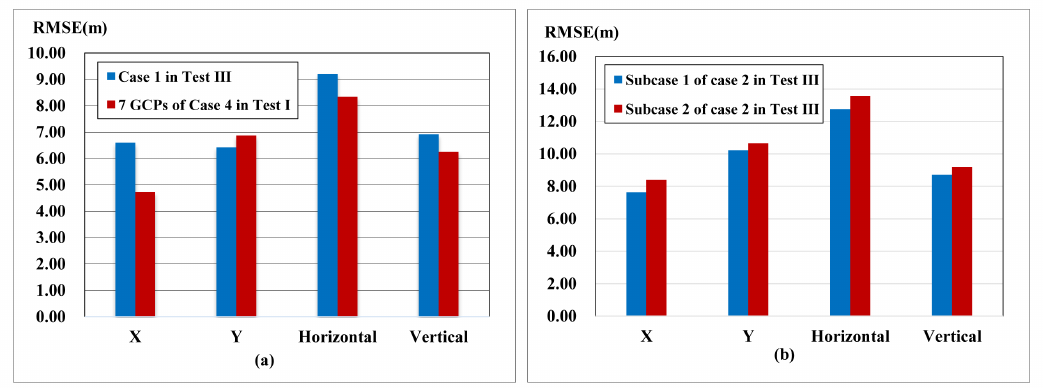
Figure 10. Accuracy of Test III: ( a ) accuracy comparison between Case 1 in Test III and Case 4 in Test I with seven GCPs; ( b ) accuracy comparison between Subcase 1 and Subcase 2 of Case 2 in Test